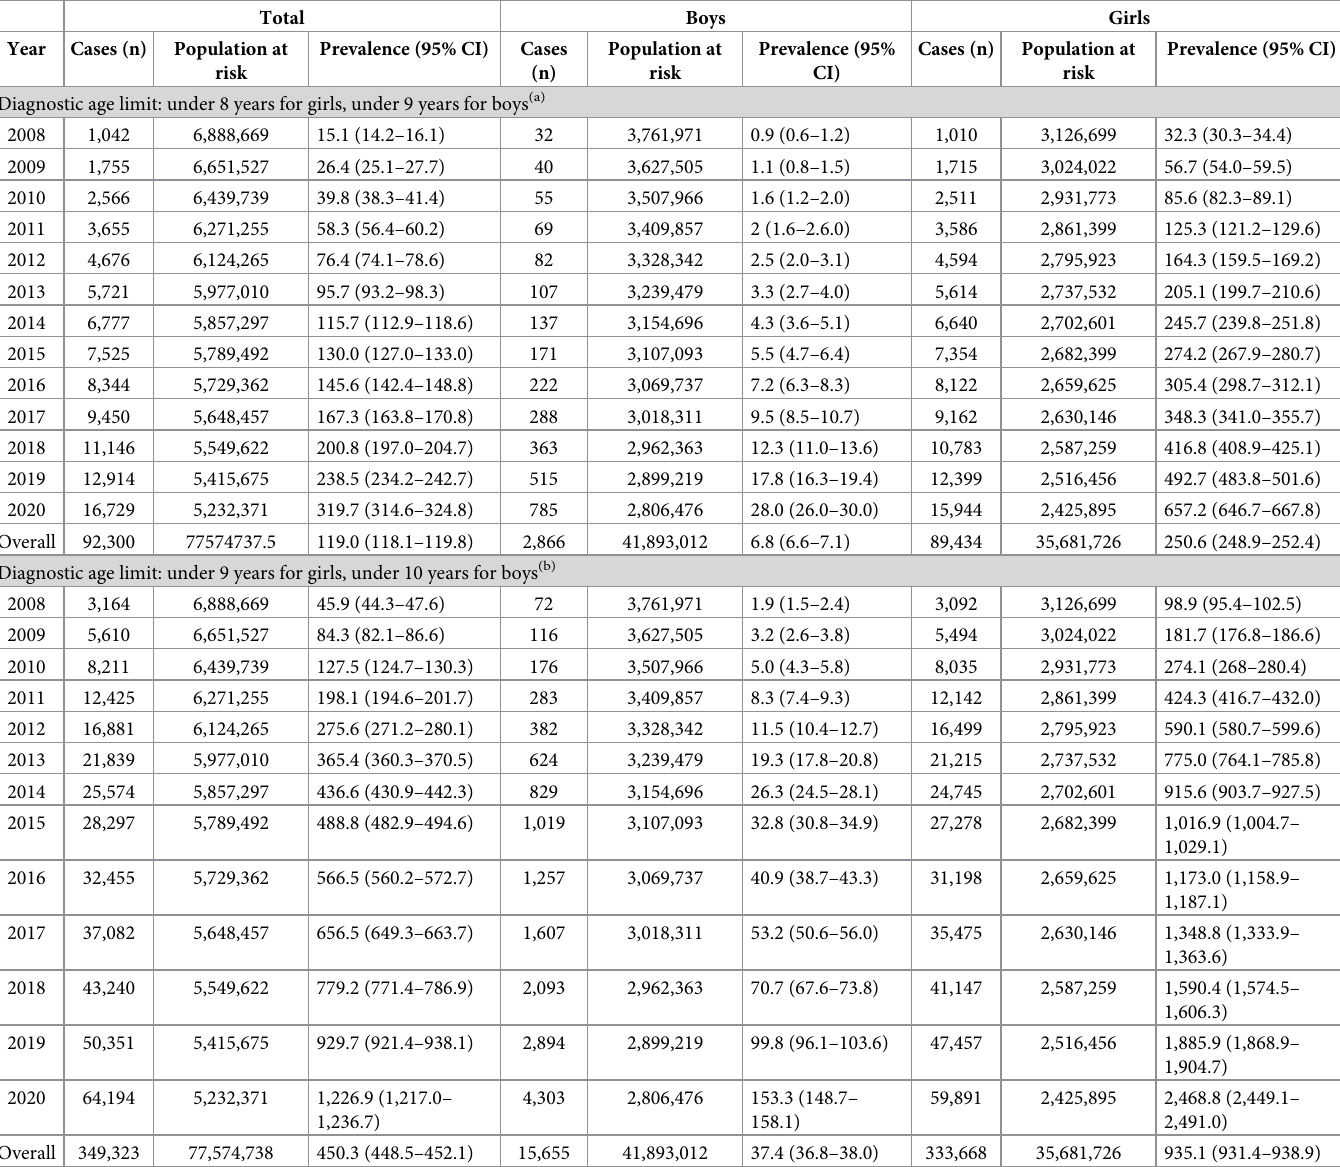
Table 3. The prevalence (95% confidence interval) of central precocious puberty according to the sex, calendar year, and two diagnostic age limits. Total Boys